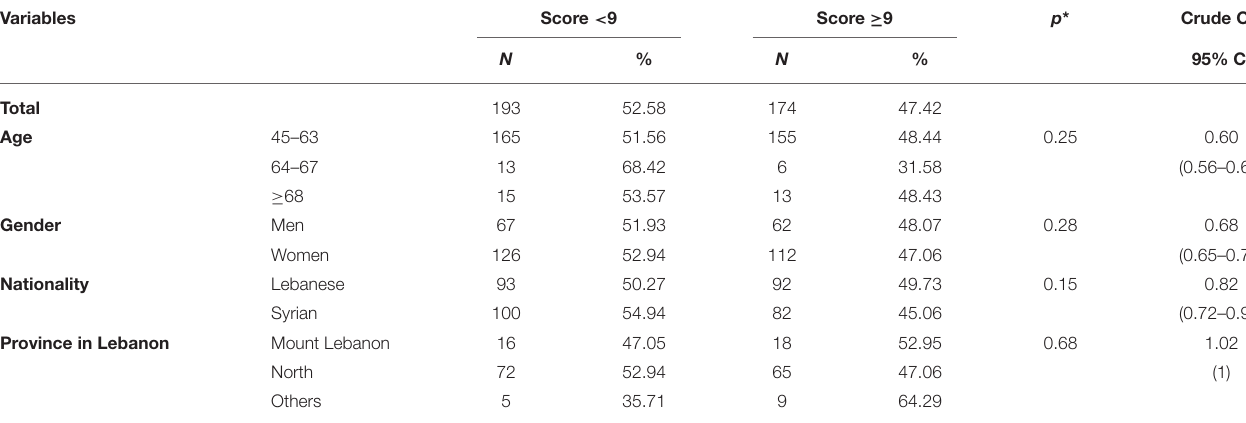
TABLE 2 | Adequacy of adherence to MedDiet according to different variables.